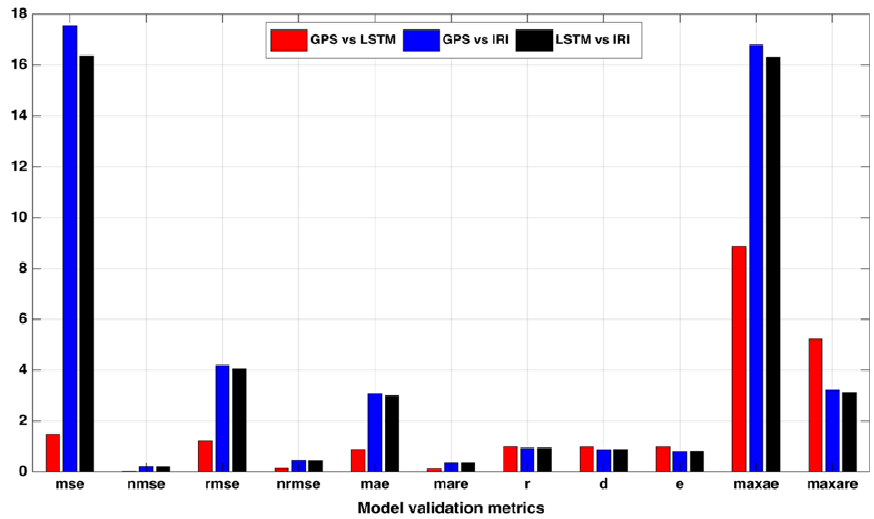
Figure 6. Model validation metrics between GPS vs. LSTM, GPS vs. IRI, and LSTM vs. IRI at a low latitude station Bangalore (IISC) in India.